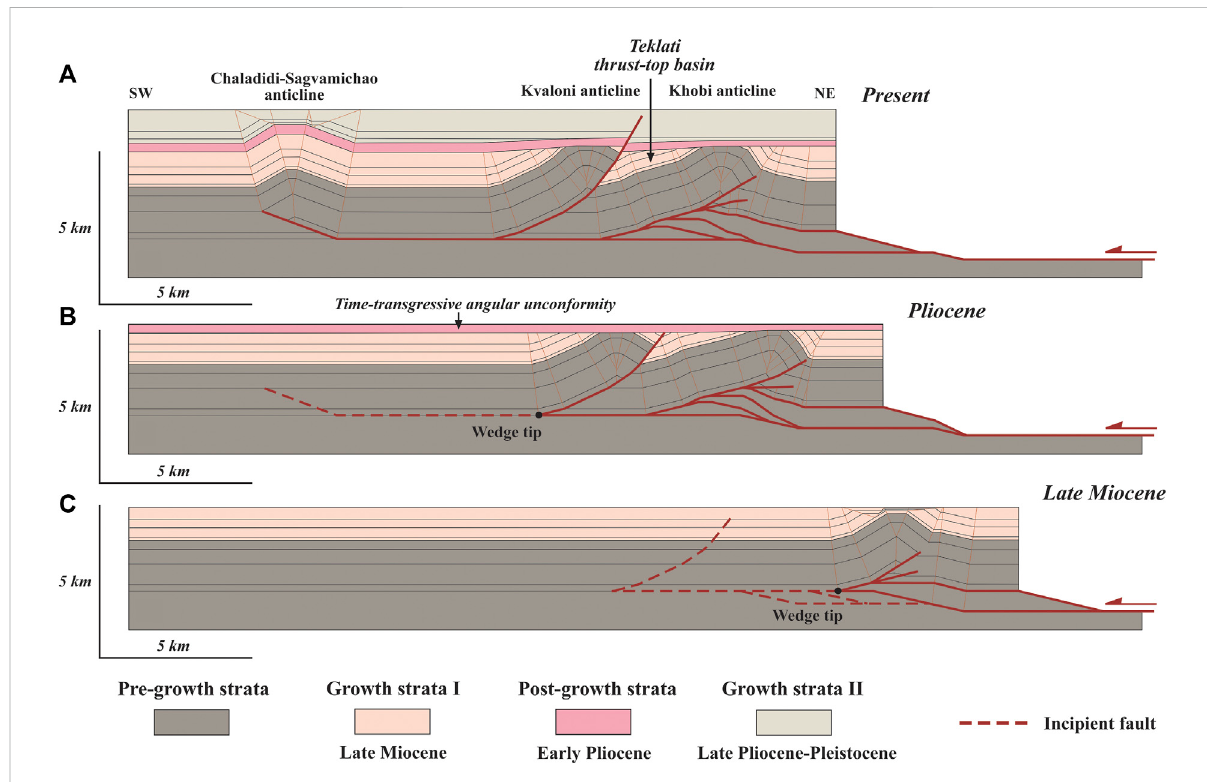
FIGURE 8 KinematicmodelsofsequentialdevelopmentoffrontalfoldsoftheRFFTB. (A) Present-day structure. (B) DeformationduringearlyPliocene. (C) Deformation during the late